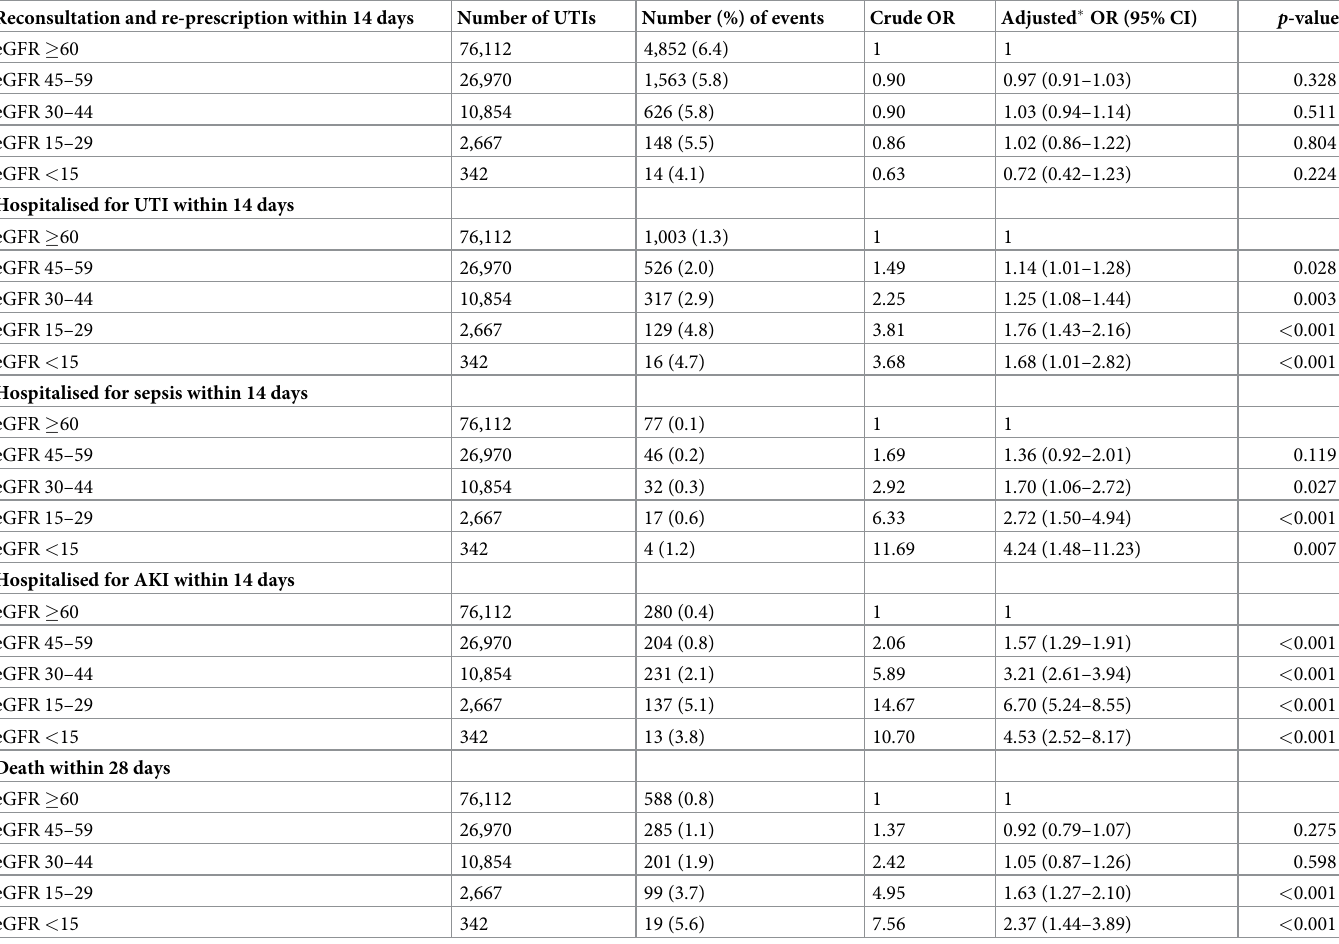
Table 2. Adjusted ORs and 95% CIs for each outcome by eGFR category. Reconsultation and re-prescription within 14